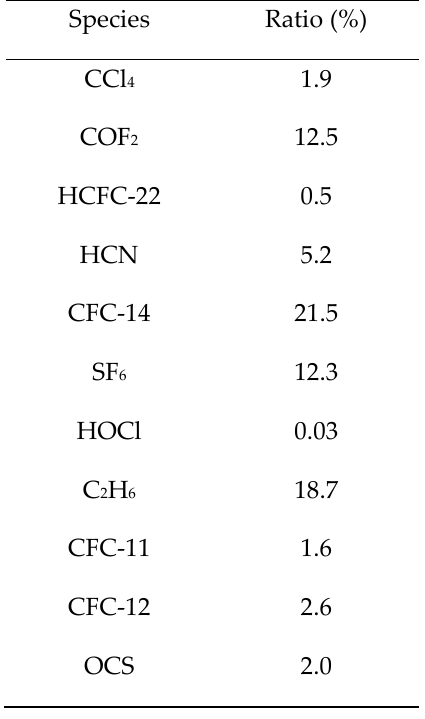
Fig. 1, Microwindows for the new species. The upper panel shows the microwindows selected for these new species retrievals. The lower panel show the spectral signatures of these Table 1, percentage of removed profiles by 5 s spike test.